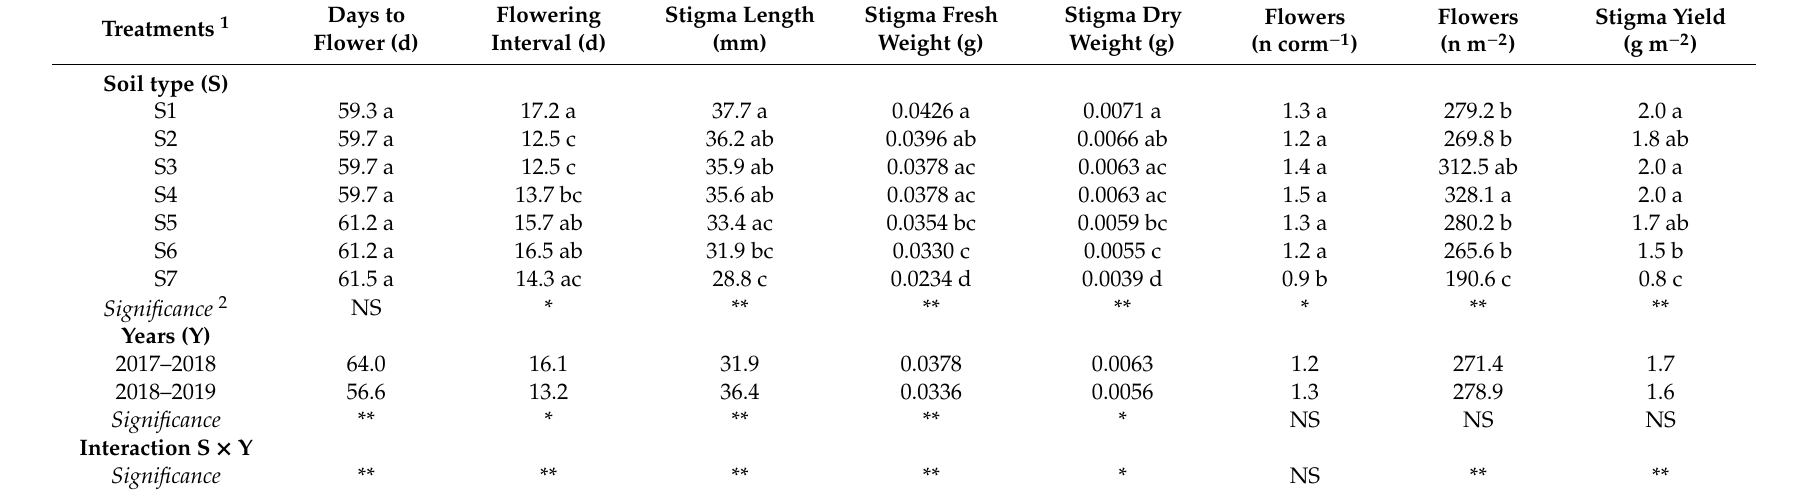
Table 3. E ff ects of the soil type on flowering and stigma yield in two